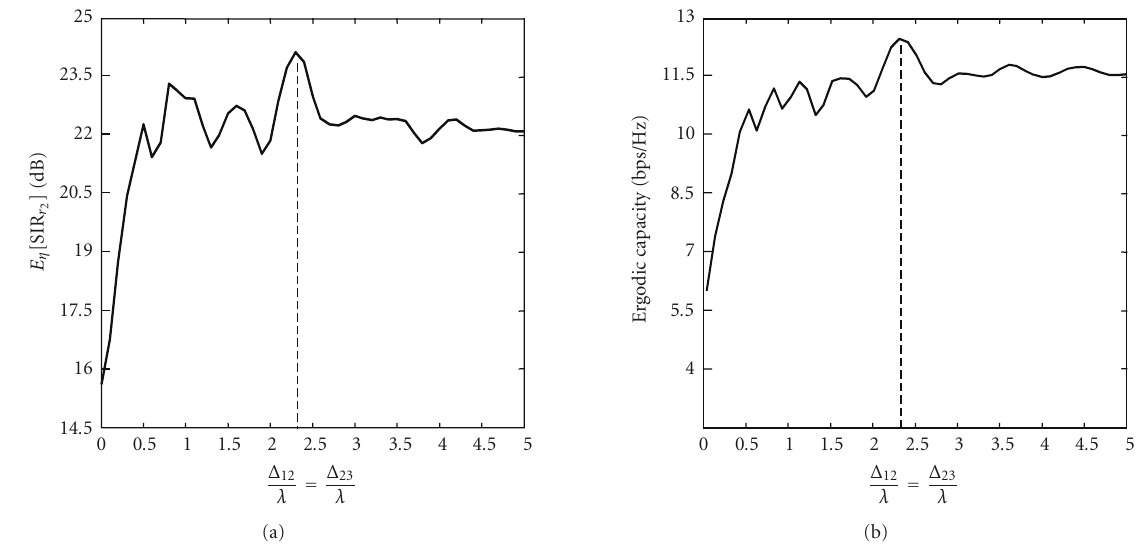
Figure 8: Setting B: rank 2 approximation of the signal-to-interference ratio E η [SIR r 2 ( Δ , η )] (a) and ergodic capacity E η [ C ( Δ , η )] (b) aver- aged with respect to the position of user and interferers within the corresponding sectors for Δ 12 = Δ 23